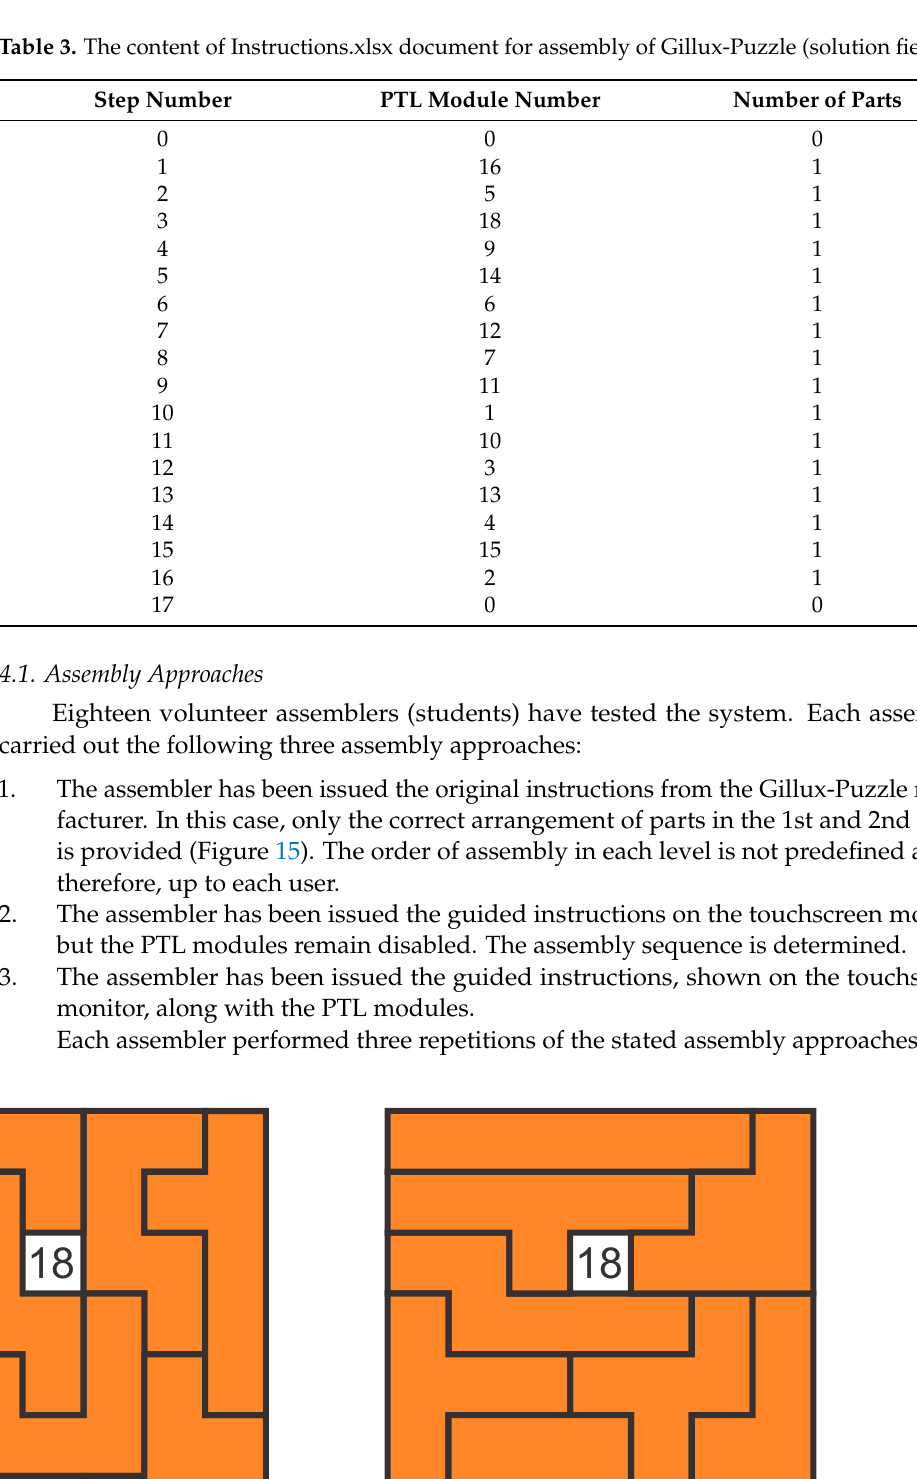
Table 4. Assembly time using original instructions.